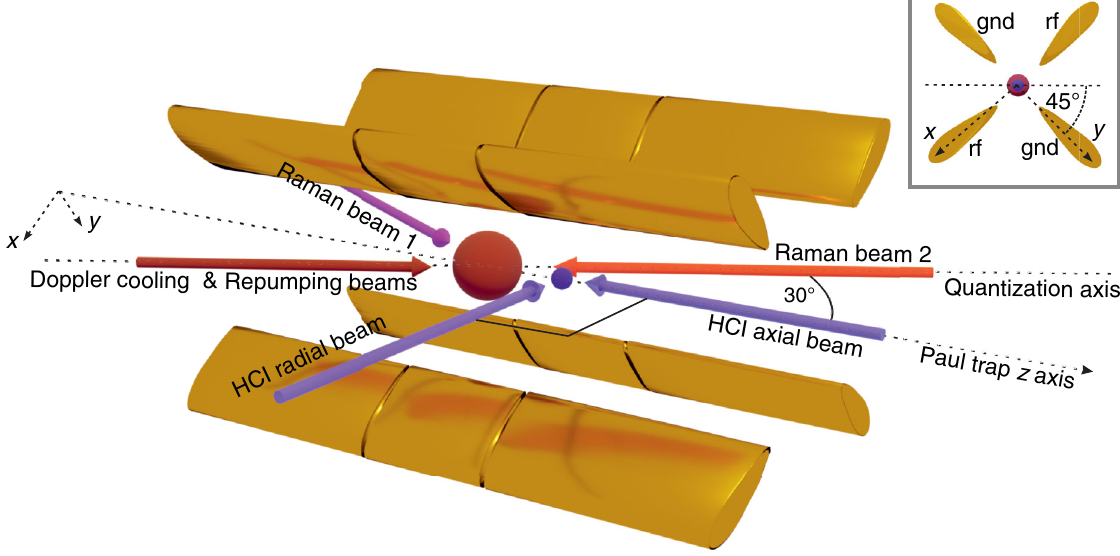
FIG. 1. Simplified depiction (not to scale) of the two-ion Coulomb crystal of a single Be þ ion (red, left) and a single HCI (purple, right) confined in a linear Paul trap. The laser beams needed for their manipulation are shown. The ions are located on the trap axis ( z ); radial motion evolves on the ( x , y ) coordinates defined by the trap electrodes, which are at 45° to the plane on which all the laser beams lie. The Doppler cooling, repumper, and Raman laser beams all intersect the z axis at an angle of 30°. The beam for addressing axial motion of the HCI is delivered along the z axis, and the beam for addressing its radial motion is delivered perpendicular to it. Inset: radial cross section of the ion trap, showing the orientation of the radial trap axes as defined by the radio-frequency (rf) and ground (gnd)